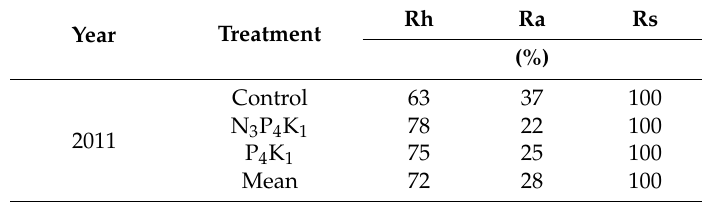
Table 3. Proportion of Rh rates from Rs rates (2011: April 2011–March 2012; 2012: April 2012–March